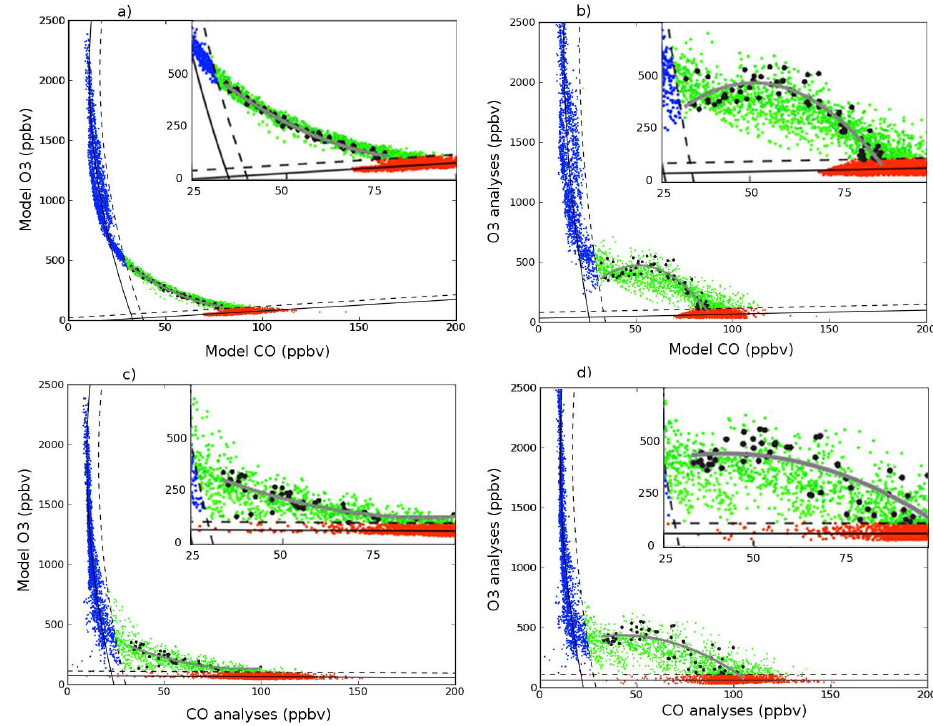
Fig. 3. Comparisons of the O 3 –CO relationships between model O 3 vs. model CO (a) , O 3 analyses vs. model CO (b) , model O 3 vs. CO analyses (c) and O 3 analyses vs. CO analyses (d) in the area between 30 ◦ W–10 ◦ E and 40–65 ◦ N on 15 August 2007 at 12:00UTC. In all cases, red and blue dots are identified as tropospheric and stratospheric model grid points, respectively. Black solid lines indicate fits to tropospheric and stratospheric values and the dashed lines are the + 3 σ values (where σ is the standard deviation of the selected data) from those fits. The green dots are identified as the transition between stratospheric and tropospheric air. The transitional points between 20 and 0 ◦ W on the 59 ◦ N vertical plane are in black and are fitted by the gray line (see text for details). Within each plot box a zoom of the transition layer is provided (top right) on each